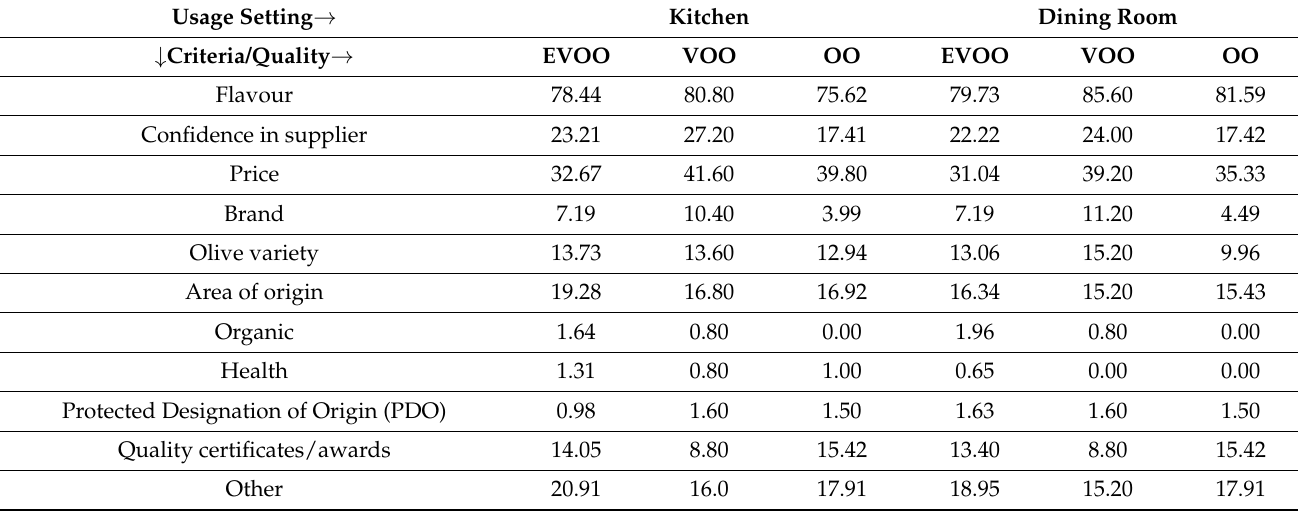
Table 2. Factors or reasons for purchase (% of subjects who name each criterion relative to total number of subjects who buy that type of oil, multiple